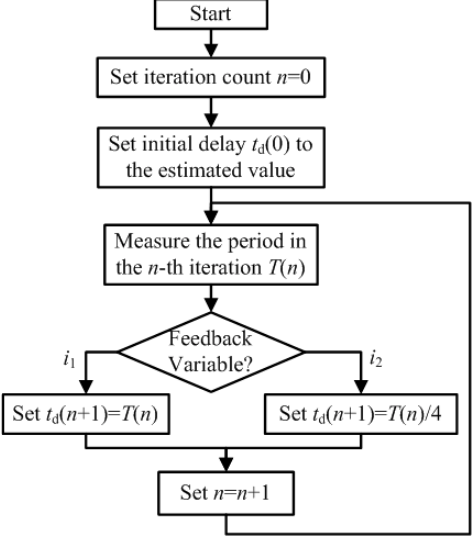
Figure 11. Flow chart of the automatic delay compensation.